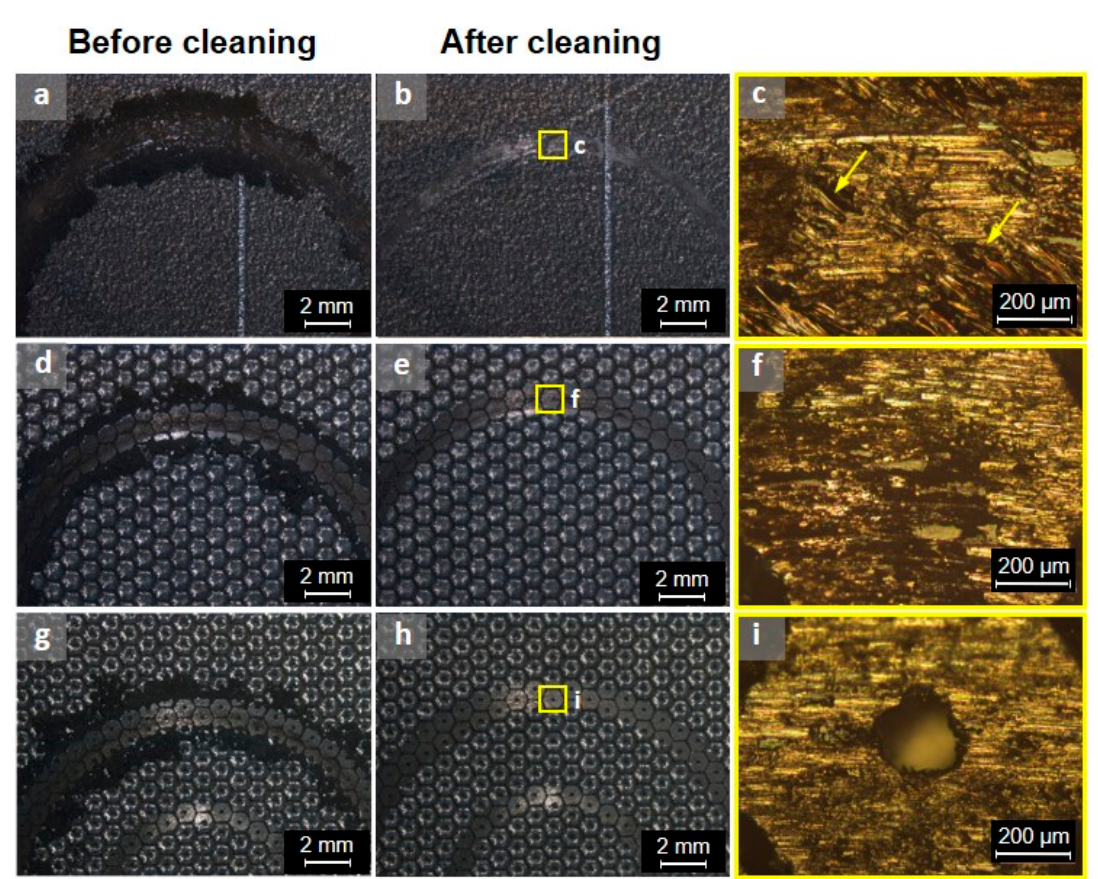
Figure 7. Wear tracks after 20,000 laps, R10_N5 tests: ( a – c ) baseline type; ( d – f ) Hex_50 type; ( g – i ) Hex-D_50 type.